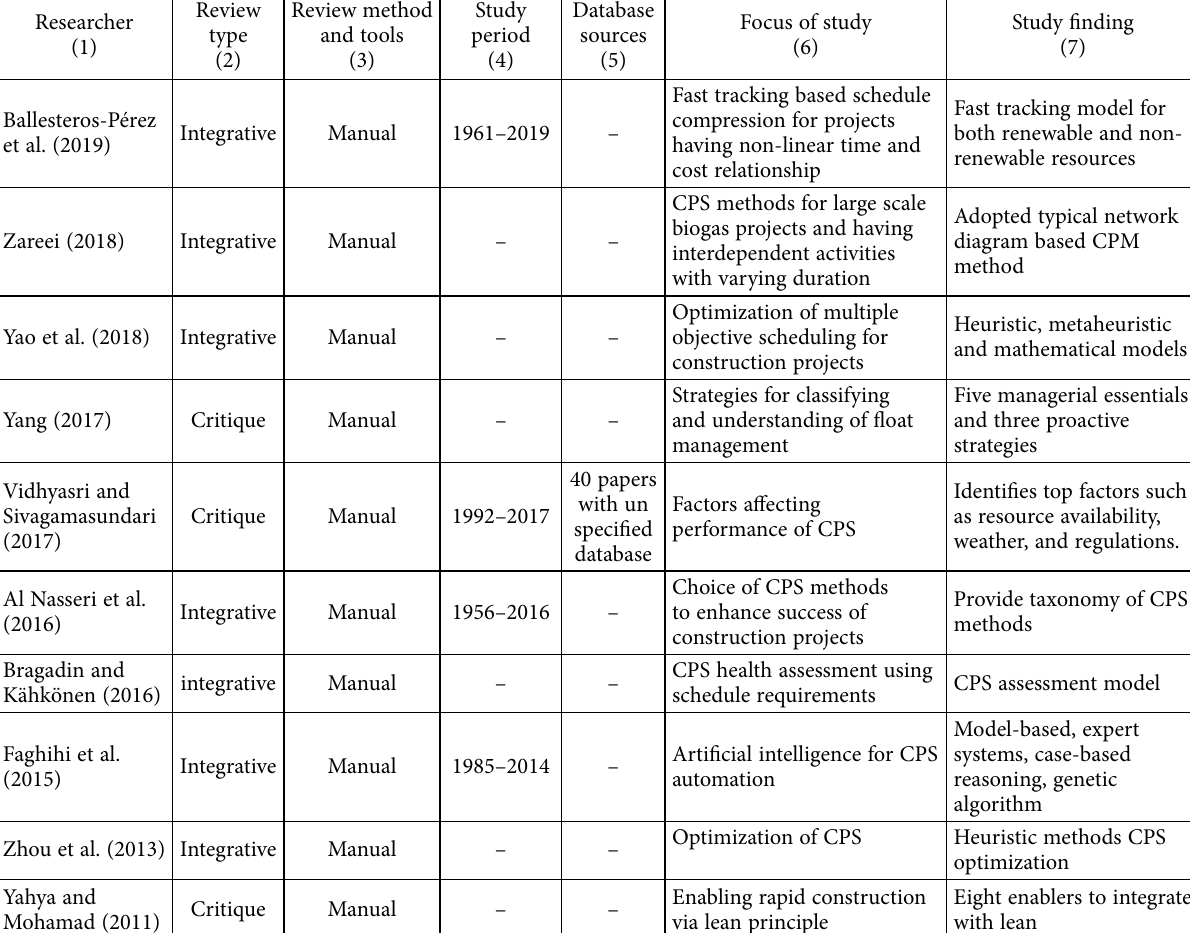
Table 1. Summary of previous peer-reviewed review